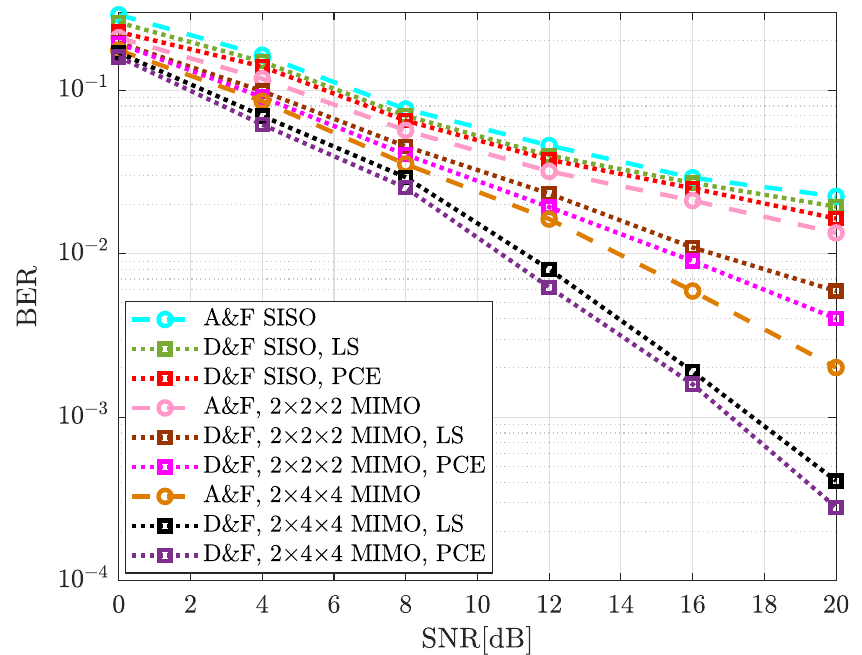
Figure 11. BER comparison for different uplink mmWave NR-RN co-operative schemes implemented with the 64-QAM